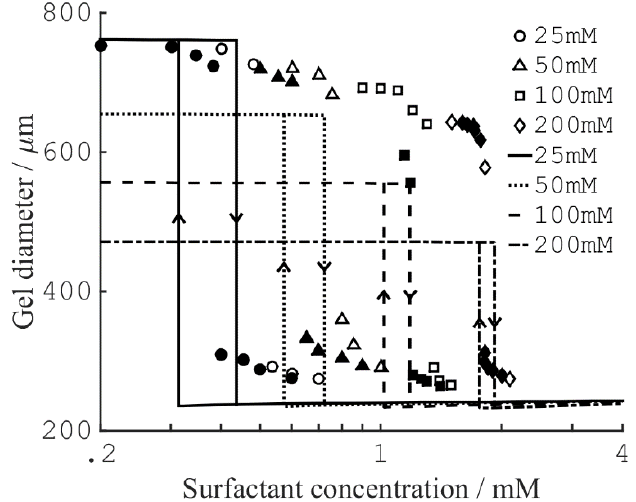
Figure 2. Collapse and swelling transitions in PA gels in solutions of dodecylpyridinium chloride (C 12 PCl) at salt concentrations as indicated. Symbols are experimental data by Sasaki et al. [15] upon increasing (open) and decreasing (filled) the surfactant concentration. Curves are calculated from theory byGernandt and Hansson. Figure is taken from ref. [68]. Reprinted with permission. Copyright 2015 American Chemical Society.